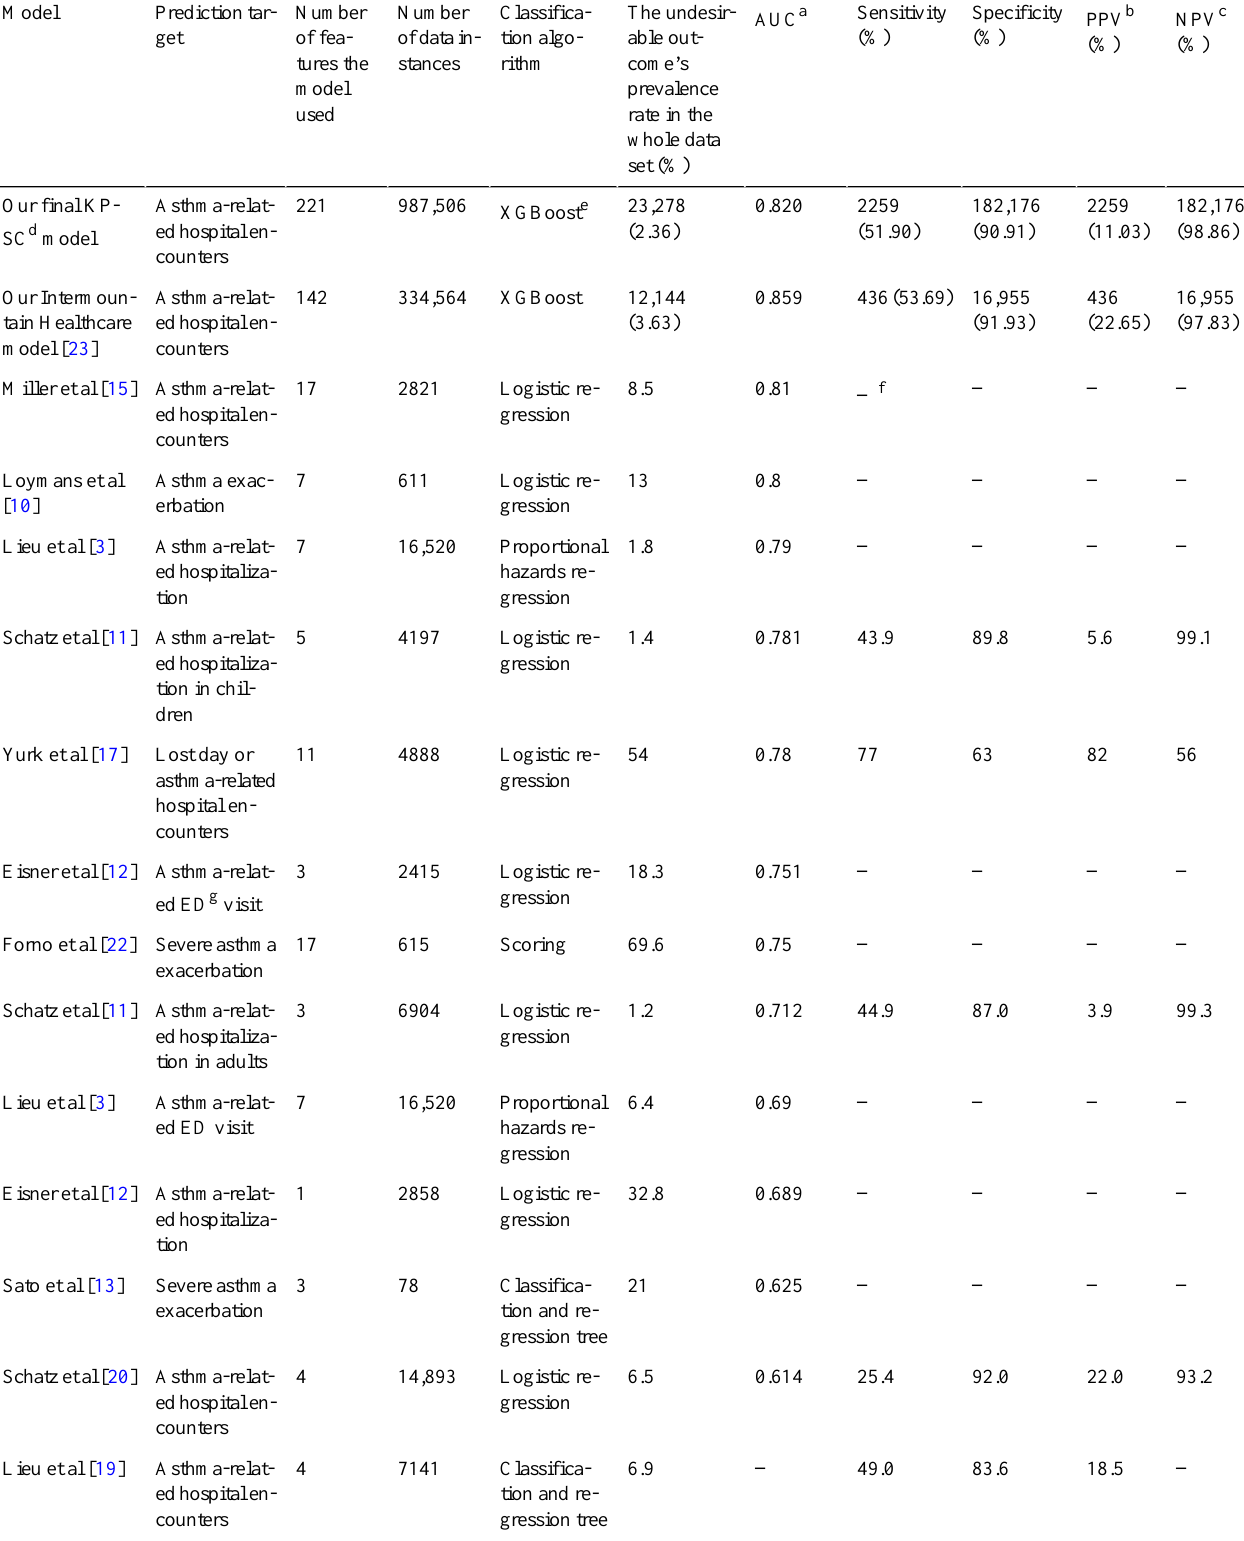
Table 5. Our final Kaiser Permanente Southern California model in comparison with several previous models for forecasting hospitalizations and emergency department visits in patients with